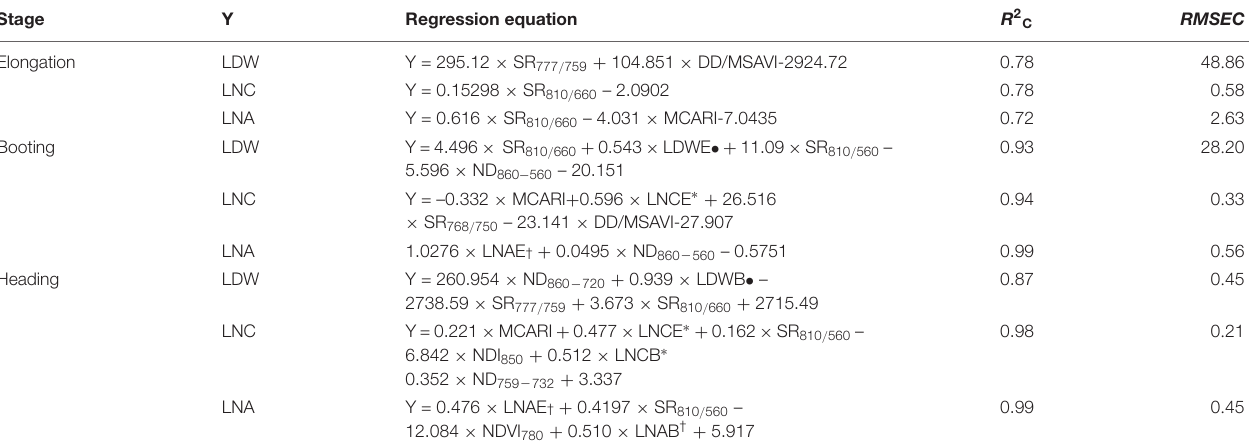
TABLE 4 | Stepwise multiple linear regression models for estimation of leaf nitrogen status indicators (LDW, LNC, and LNA) over growth stages of